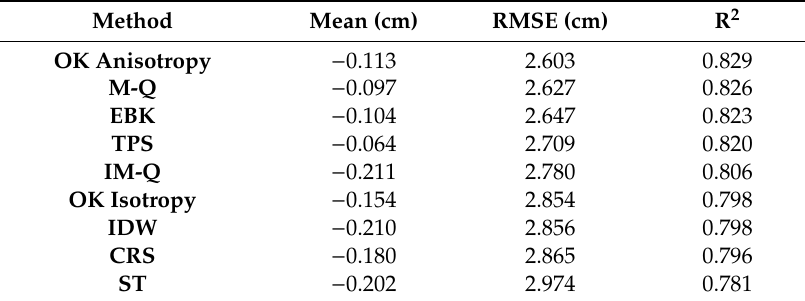
Table 2. Results obtained from the interpolation